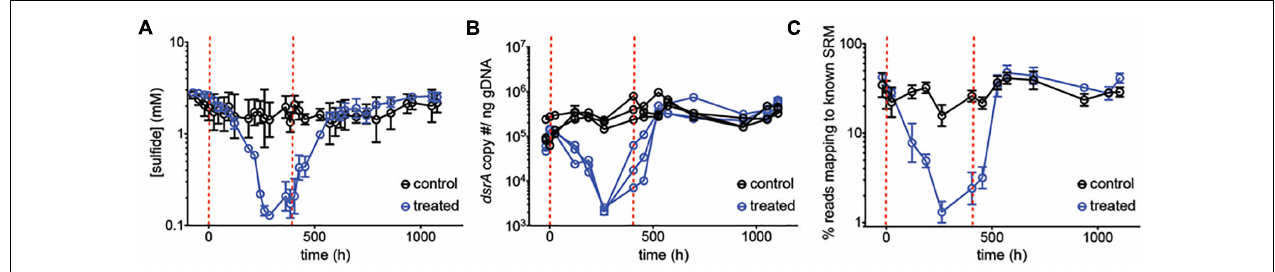
FIGURE 1 | (A) Average sulfide production, (B) dsrA copy number per ng genomic DNA and (C) percentage of reads mapping to known SRM, based on 16S amplicon sequencing, over time for control chemostats (black circles) and chemostats treated with 50 mM perchlorate (blue circles). Dashed red lines indicate start and stop of treatment. Error bars represent SD from 3 replicates, except in (B) where replicates are graphed independently.